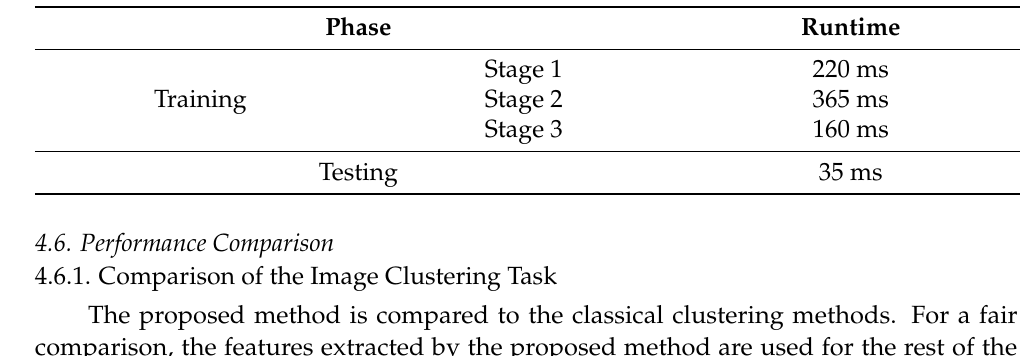
Table 4. Running time of the model on a batch in each phase.